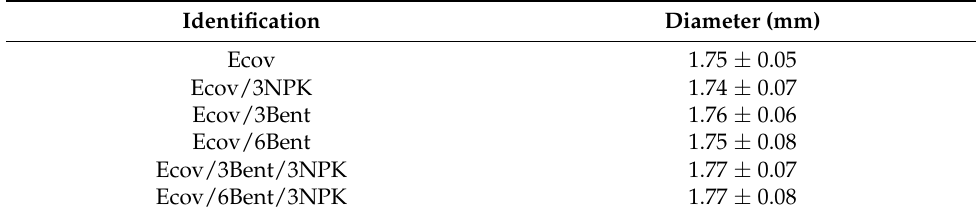
Table 2. Filament diameters.